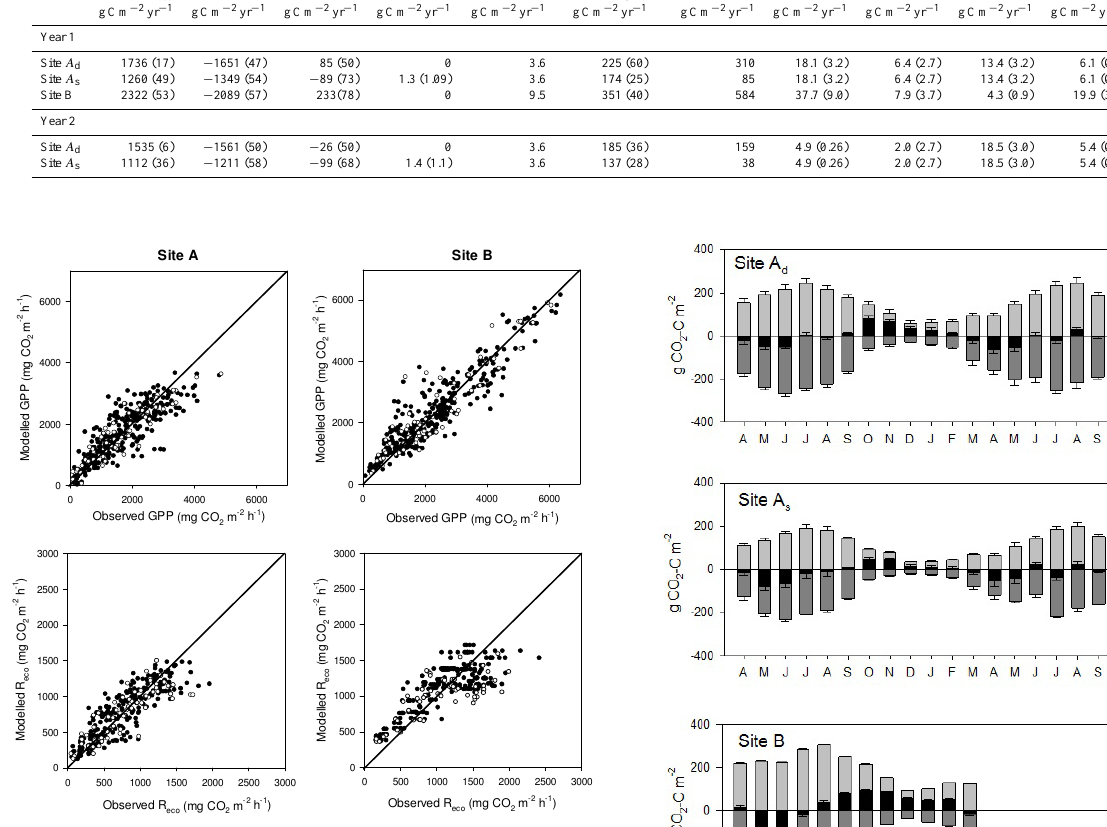
Figure 4. Relationship between observed and modelled Gross Pri- Fig. 4. Relationship between observed and modelled Gross Primary Production (GPP) mary Production (GPP) and Ecosystem Respiration ( R eco ) fluxes and Ecosystem Respiration (R eco ) fluxes (mg CO 2 m -2 h -1 ) for Sites A and B. Dark circles (mgCO 2 m − 2 h − 1 ) for Sites A and B. Dark circles indicate data indicate data used in the construction of models and open circles indicate independent used in the construction of models and open circles indicate inde- test data. pendent test data.